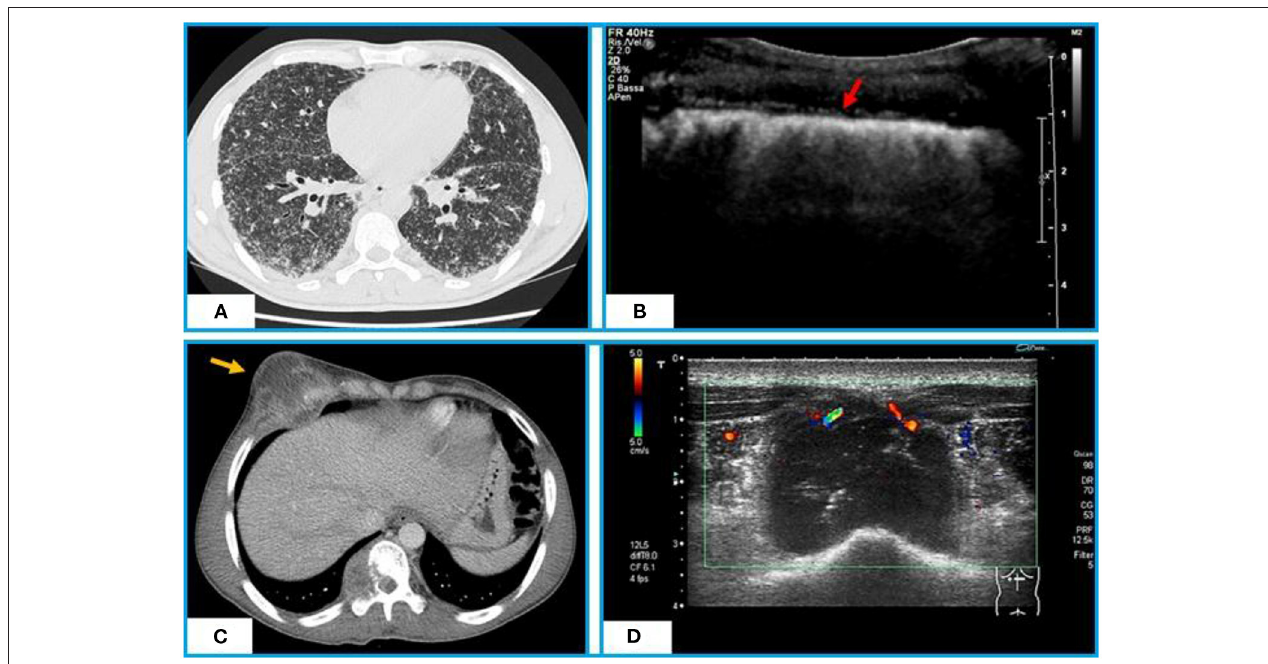
FIGURE 2 | Chest CT and TUS appearance of miliary TB. (A) Axial CT scan shows hundreds of minutes “millet grain” nodules with a typical random distribution. (B) TUS highlights a marked irregularity of the hyperechoic pleural line (red arrow), that appears as blurred and fragmented. Chest CT and TUS appearance of a tuberculous abscess of the anterior chest wall. (C) Axial CT scan with contrast shows a tuberculous abscess with a low-attenuation central necrotic component and capsular ring enhancement extending from the pleura to right chest wall and infiltrating the rib and soft tissues. (D) TUS scan shows a hypoechoic collection in right antero-lateral chest wall with internal echo-debris and no Color-Power Doppler inner